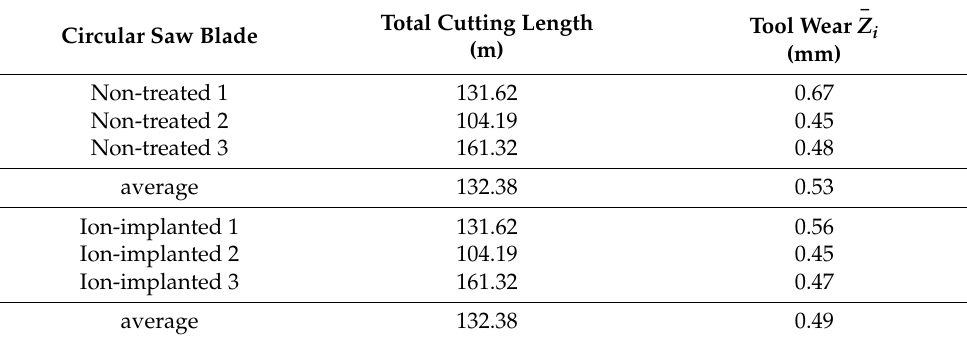
Table 3. Total cutting length and wear of circular saw